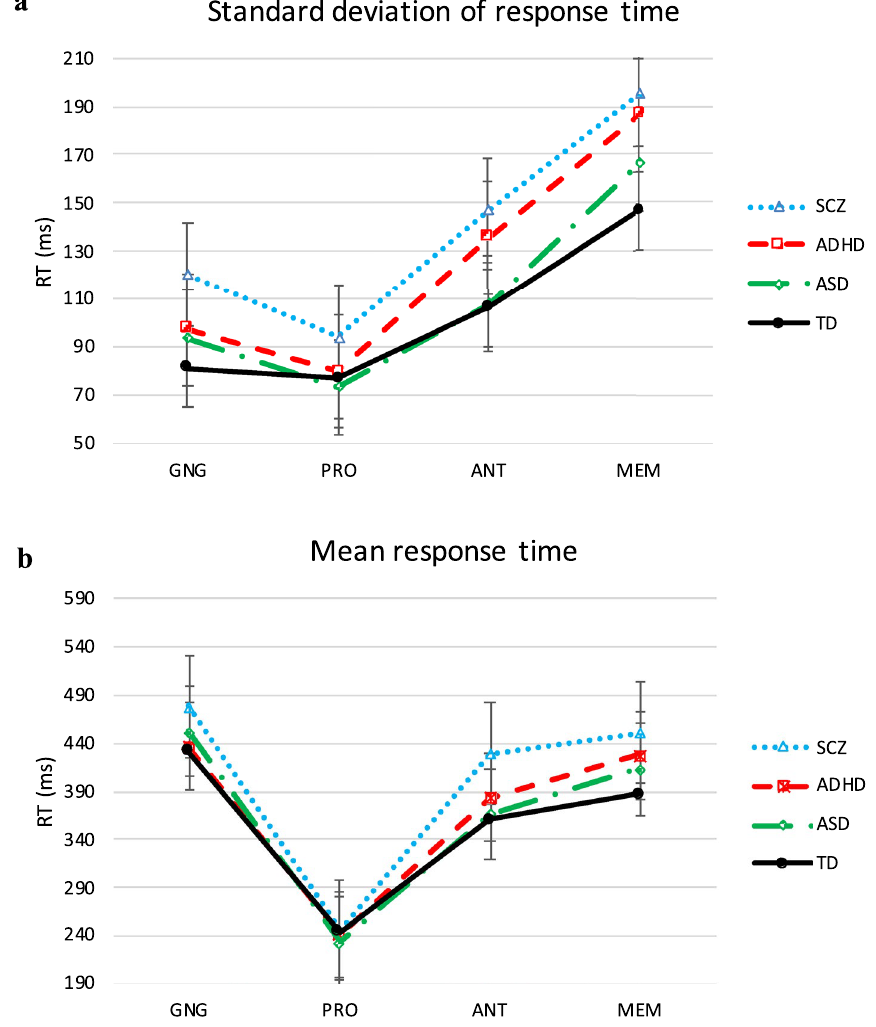
Figure 2. ( a ) Standard deviation and ( b ) Mean of RT for correct response from GNG, PRO, ANT, MEM. Error bars represent one standard error of the mean. The effect sizes from the between-group subject ANOVA are also reported here. Standard deviation of RT: GNG: η p 2 = 0.117, PRO: η p 2 = 0.041, ANT: η p 2 = 0.103, MEM: η p 2 = 0.04. Mean RT: GNG: η p 2 = 0.069, PRO: η p 2 = 0.026; ANT: η p 2 = 0.096; MEM: η p 2 =